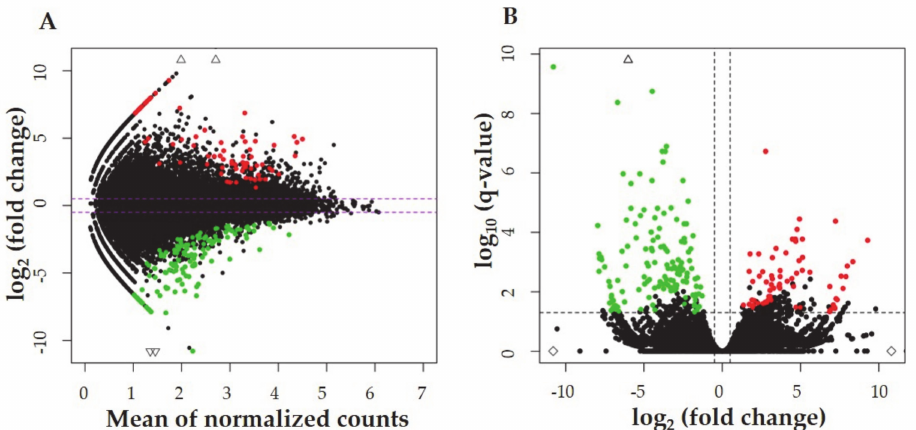
Figure 1. ( A ) MA plot depicts the logarithmic scale of the fold changes (logFC) in the Y –axis, and the count mean expression in the X –axis. ( B ) The volcano plot describes logFC in the X –axis and logarithmic adjusted p -value in the Y –axis. Red dots illustrate upregulated transcriptionally active regions (TARs), green dots represent downregulated